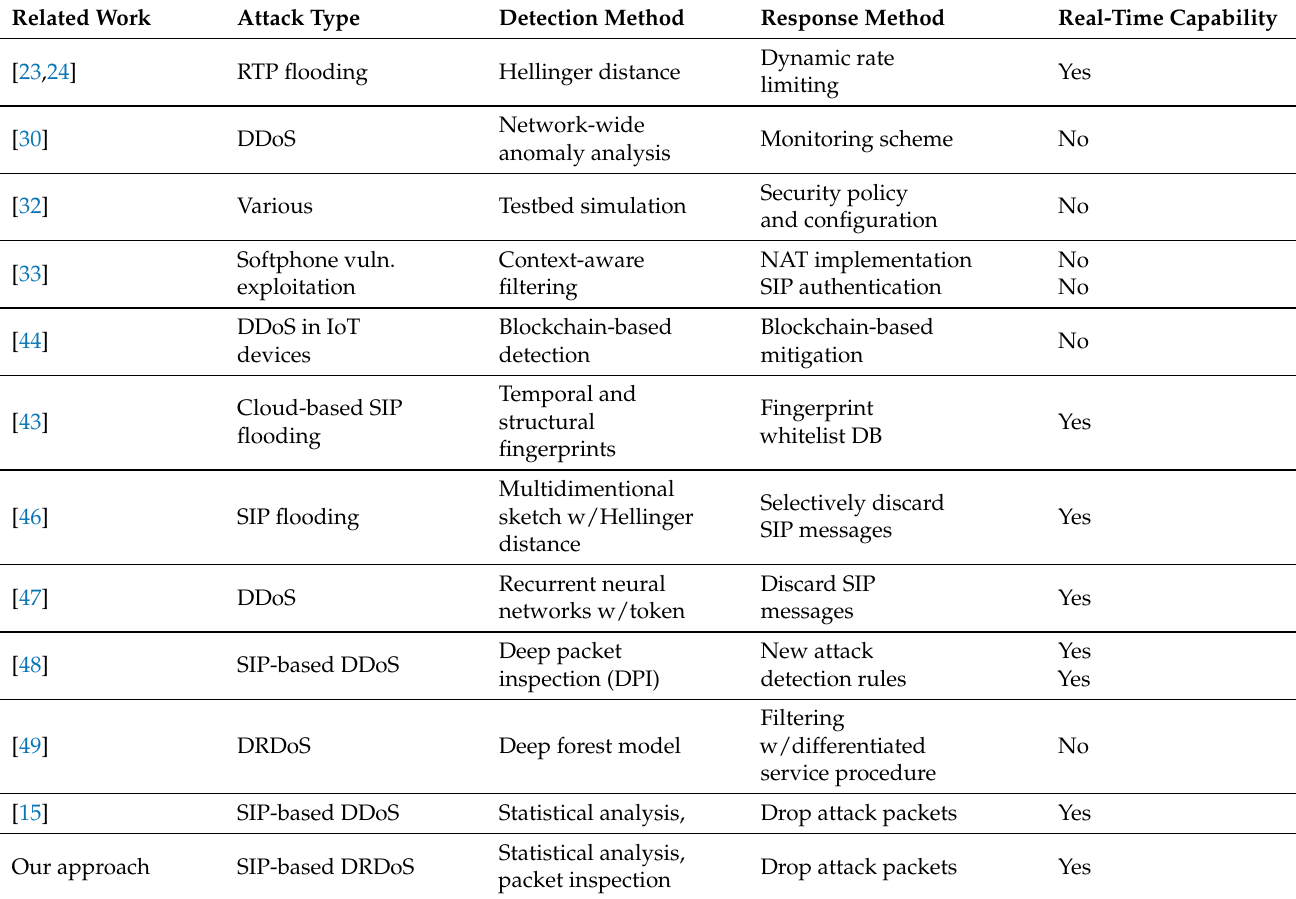
Table 1. Comparison of the related works on SIP-based DDoS defense